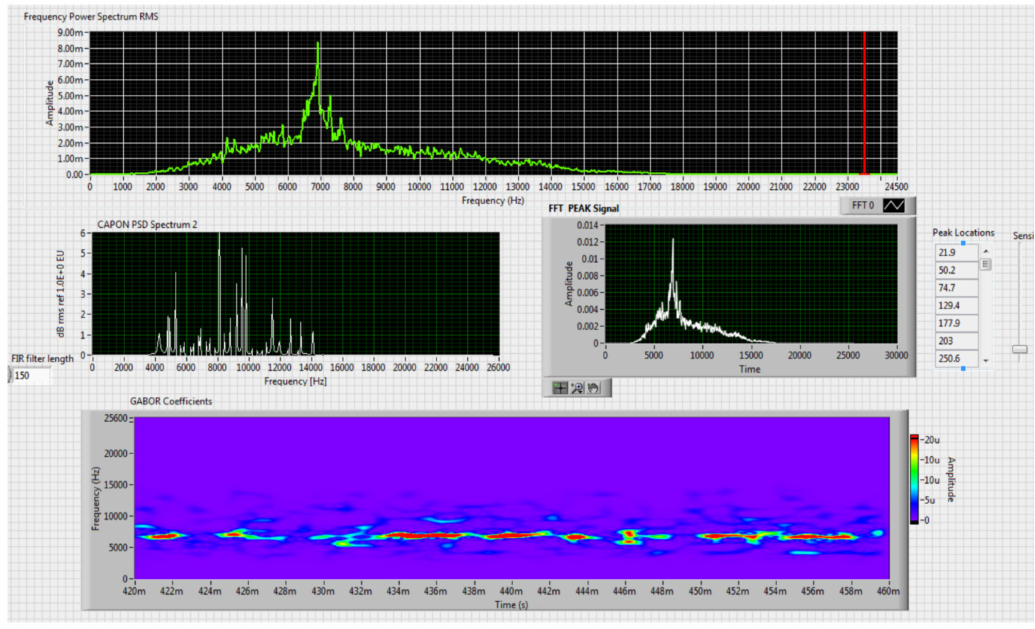
Figure 17. Results obtained for stationary distance 130 m, altitude 2 m.